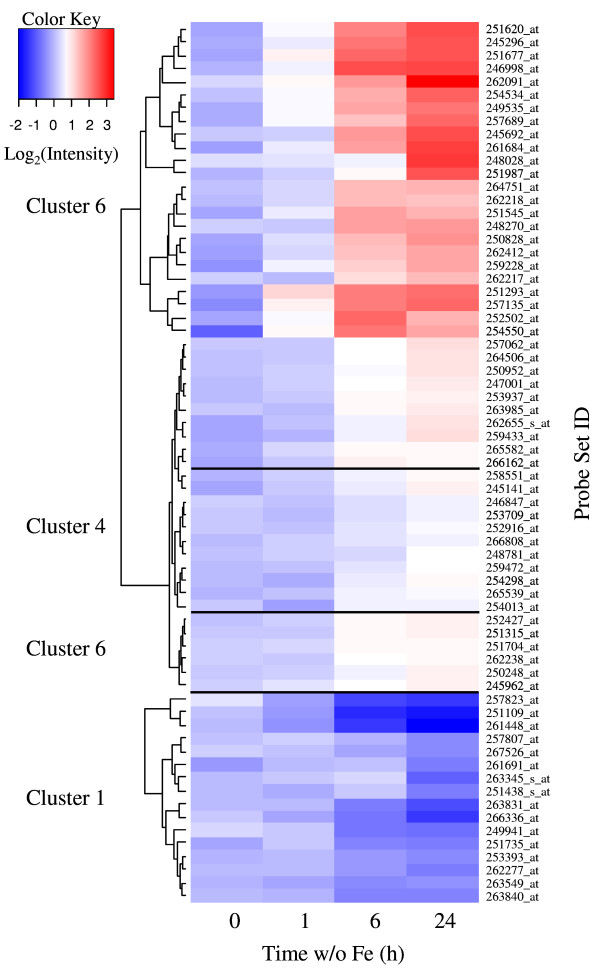
Heatmap analysis of changes in transcript abundance in Arabidopsis roots grown under Fe deficiency. The fine structure of clusters one and six were investigated. Changes in response to Fe deficiency with a p-value of < 0.05 were selected for analysis. In a detailed analysis, several transcripts that were grouped into cluster 4 by an analysis of all transcripts showed an overlap with cluster six. The overlapping members of cluster 4 are also shown in the figure.